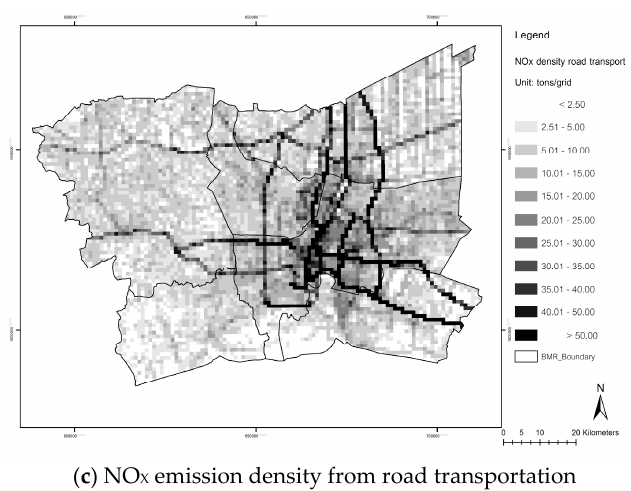
Figure 15. Spatial allocation of NO X emission in the BMR, 2015: ( a ) light duty vehicles and motorcycles; ( b ) heavy duty vehicles; ( c ) road transportation.